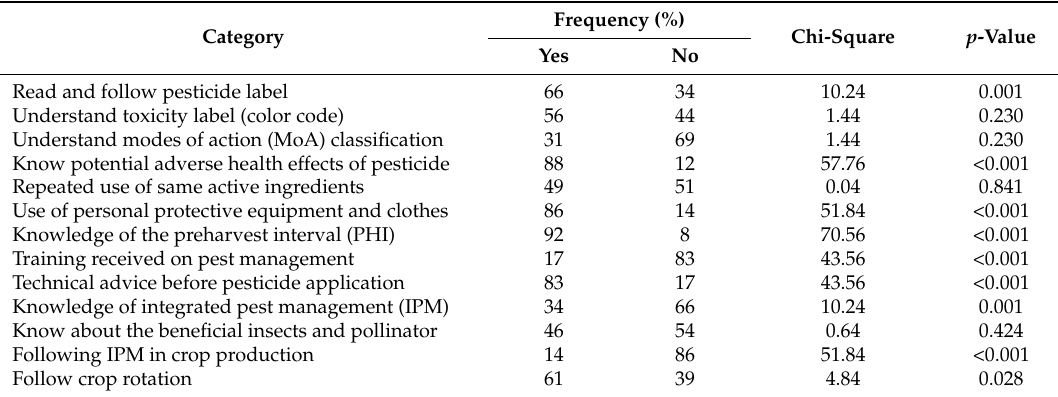
Table 4. Common practices, strategies to reduce chemical exposure, and technical know-how of pesticide application among commercial vegetable growers in Chitwan,